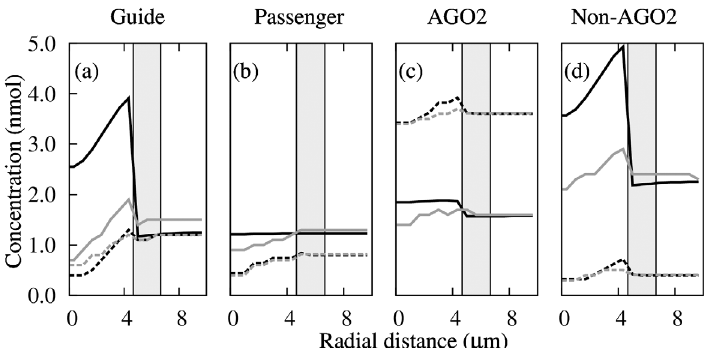
Fig 5. Radial density profiles. Radial density profiles of (a) guide strand, (b) passenger strand, (c) AGO2 protein, and (d) non-AGO proteins with target in the nucleus under four conditions: T = 10 nmol, p d = 0.4 (solid black); T = 2 nmol, p d = 0.4 (solid gray); T = 10 nmol, p d = 0.9 (dashed black); T = 2 nmol, p d = 0.9 (dashed gray). In all cases s d = 0.6. Colored strip in panels indicate the perinuclear